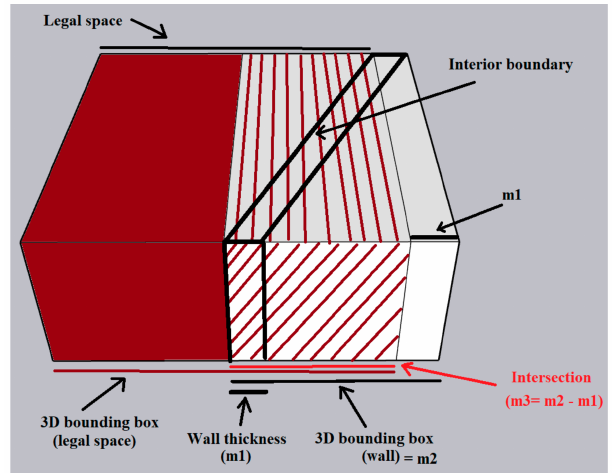
Figure 12. Using (thickness of intersection between 3D bounding box of the wall and 3D bounding box of legal space) for identifying an Exterior boundary (a vertical wall).